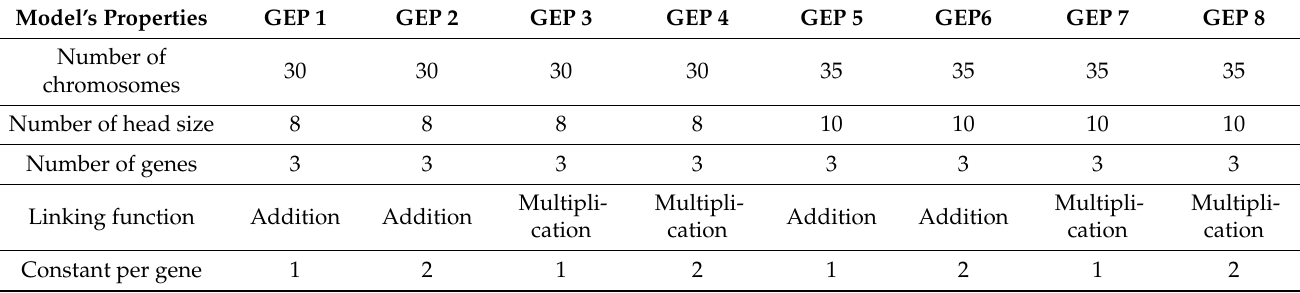
Table 7. Properties of different Gene Expression Programming (GEP)